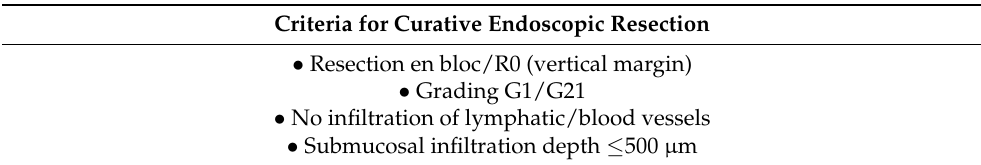
Table 2. Criteria for curative endoscopic resection of Barrett’s cancer